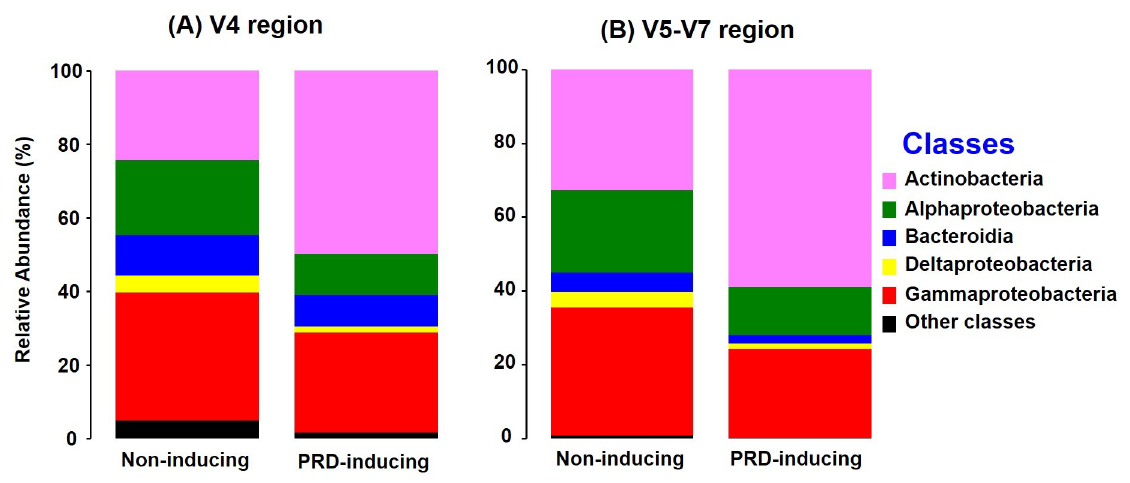
Fig 4. Composition of bacterial communities in peach roots from the six soils that were PRD-inducing and four that were non-inducing in the greenhouse bioassay. A and B , class-level relative abundances of ASVs resolved from amplicons of V4 (primers 515F-806R) and V5-V7 (primers 799F-1199R) regions of the rRNA gene, respectively. The soil portions (controls) were those left untreated before the bioassay. ASV abundances were calculated after rarefication.